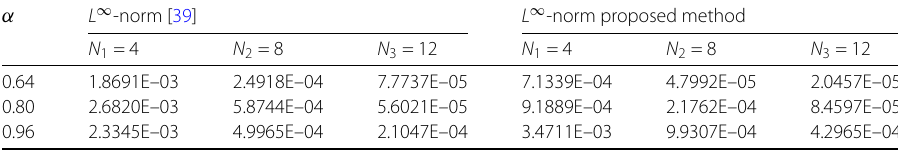
, τ = 1 at T = 1 for Problem 2 N N 2